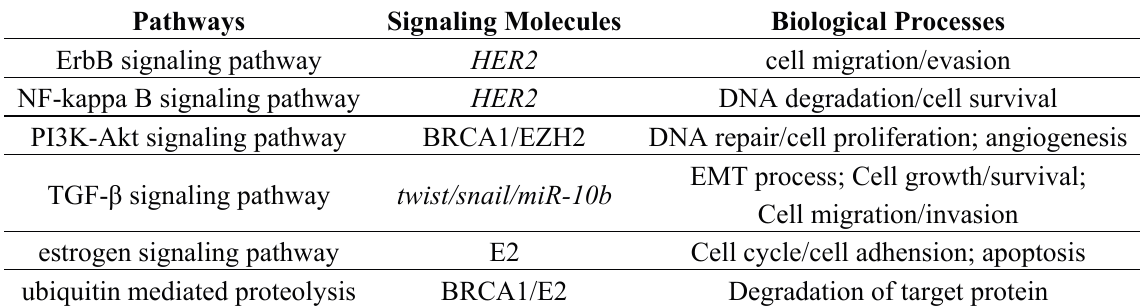
Table 3. HOTAIR -related signaling pathways/processes in BC.